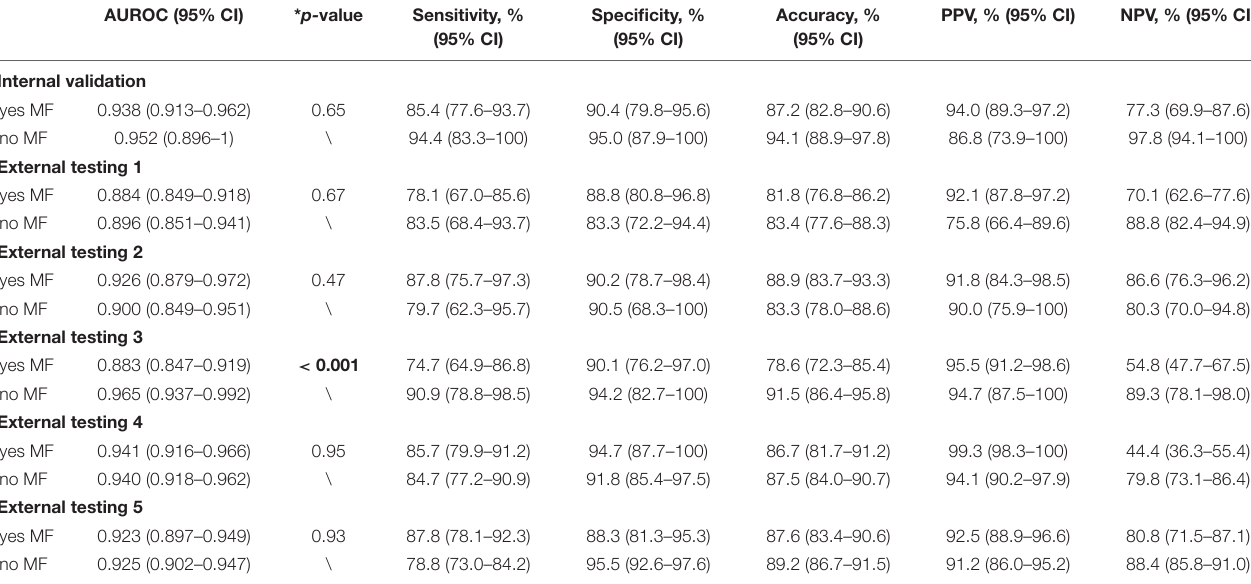
TABLE 3 | Subgroup analysis for detecting glaucomatous optic neuropathy in groups stratified by yes/no myopic